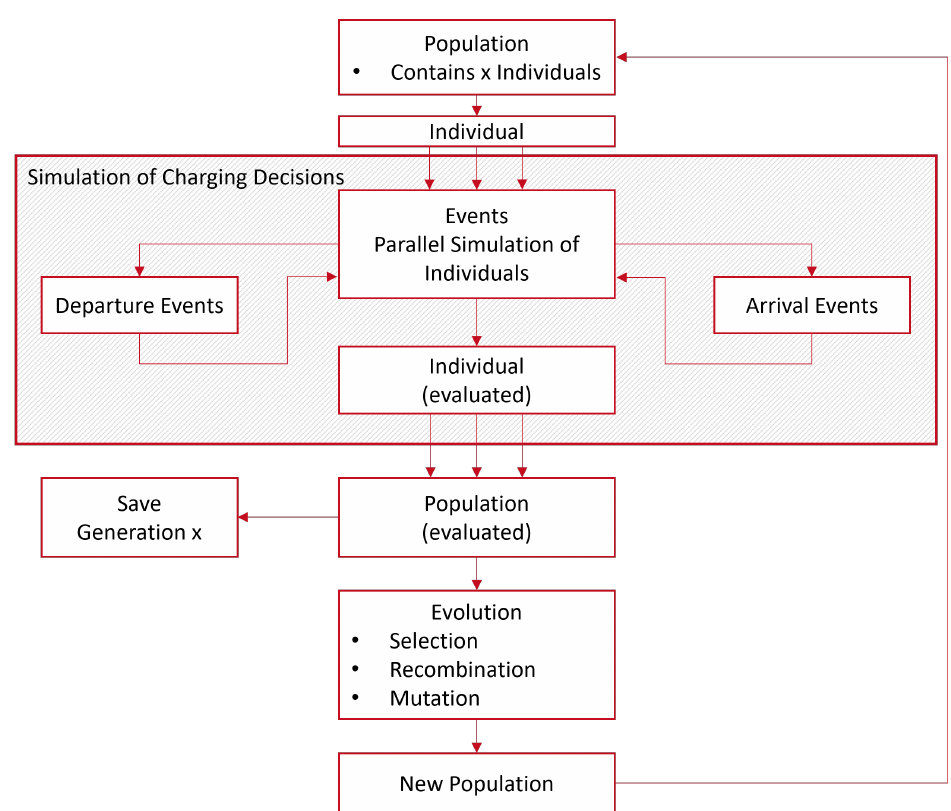
Figure 5. Representation of the methodological